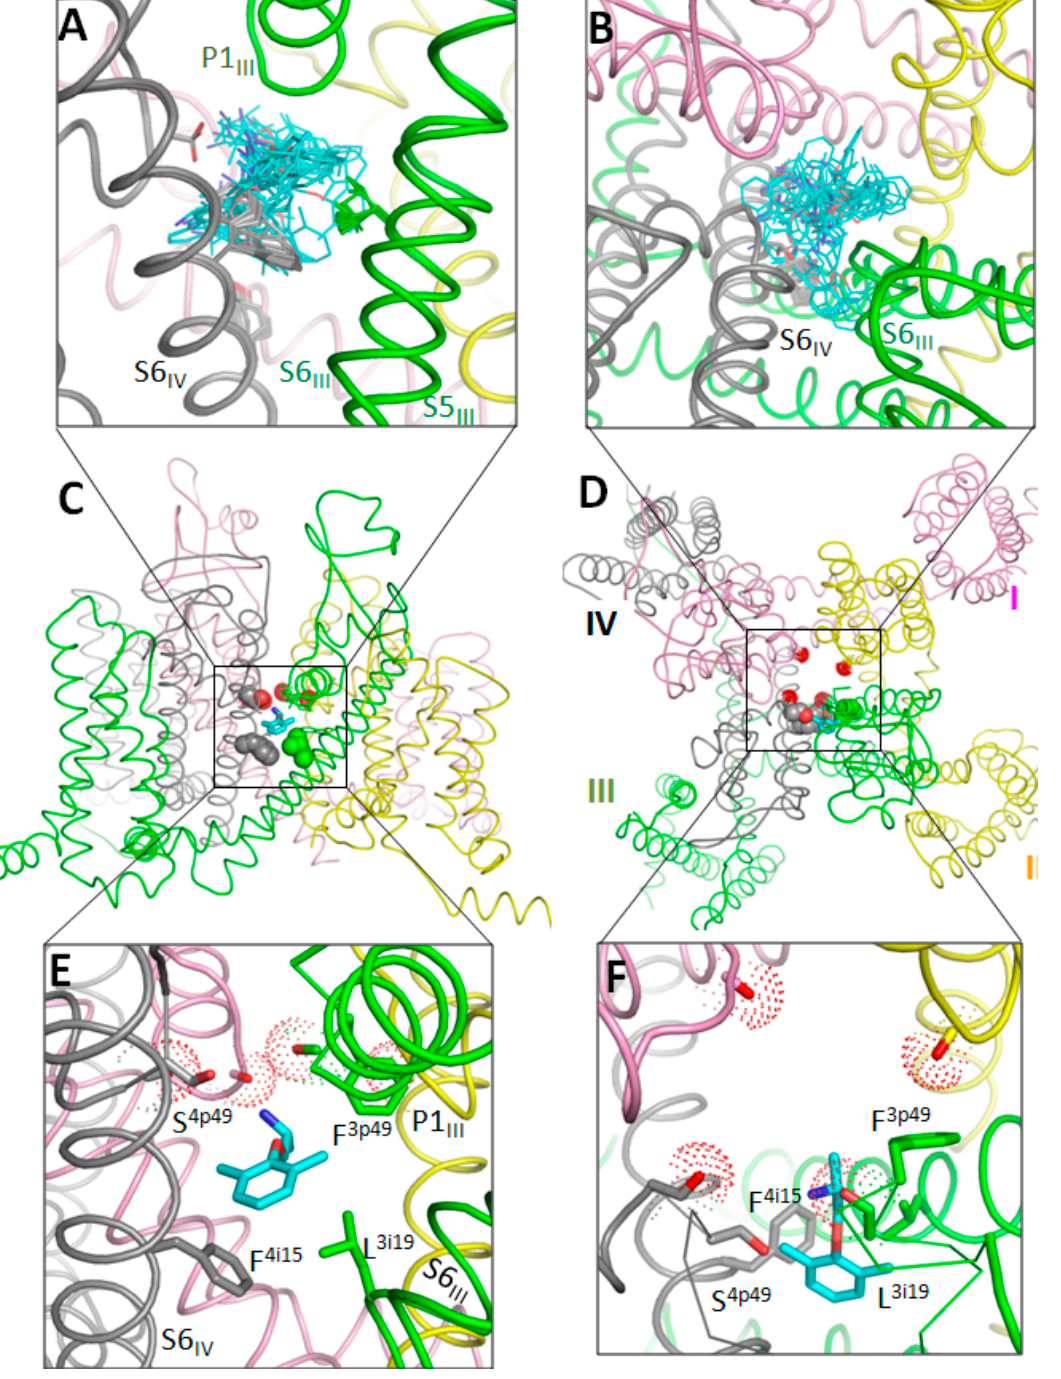
Figure 1. MEX in hNa1.5. Repeats I, II, III and IV are pink, yellow, green and gray, respectively. Carbon atoms in MEX are cyan. ( A , B ). Membrane ( A ) and extracellular ( B ) views of top 50 docking poses after refinement of hundreds randomly generates initial structures. ( C , D ) Intra-membrane ( C ) and extracellular ( D ) views of the Nav1.5 channel with a representative MEX docking pose in the III/IV fenestration, which presumably corresponds to TB. Space-filled are residues, which are in direct contact with MEX and whose mutations are known to affect the MEX TB. Backbone carbonyls in the outer pore (two positions N-terminal to the DEKA selectivity-filter ring), which create an electronegative site attractive for cationic ligands, are shown by sticks surrounded by dots. ( E , F ) Expanded views of panels ( C , D